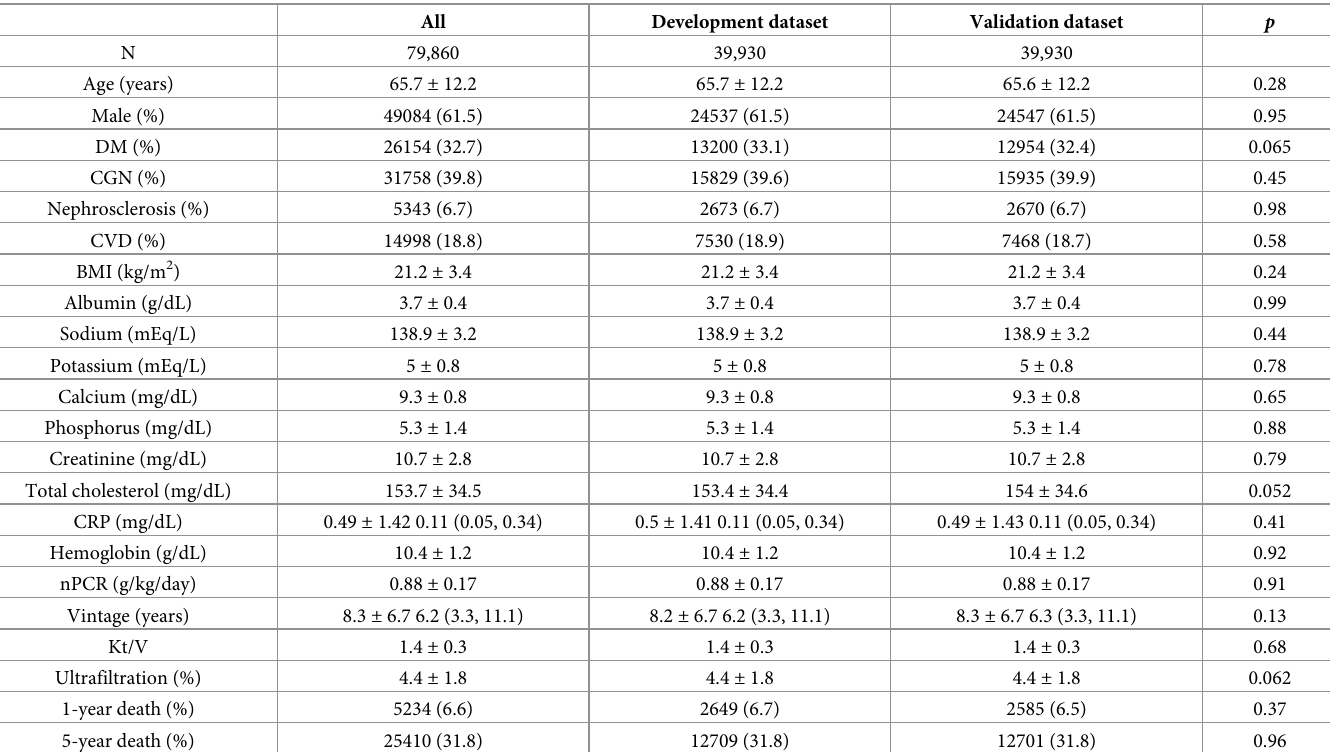
Table 1. Baseline characteristics.